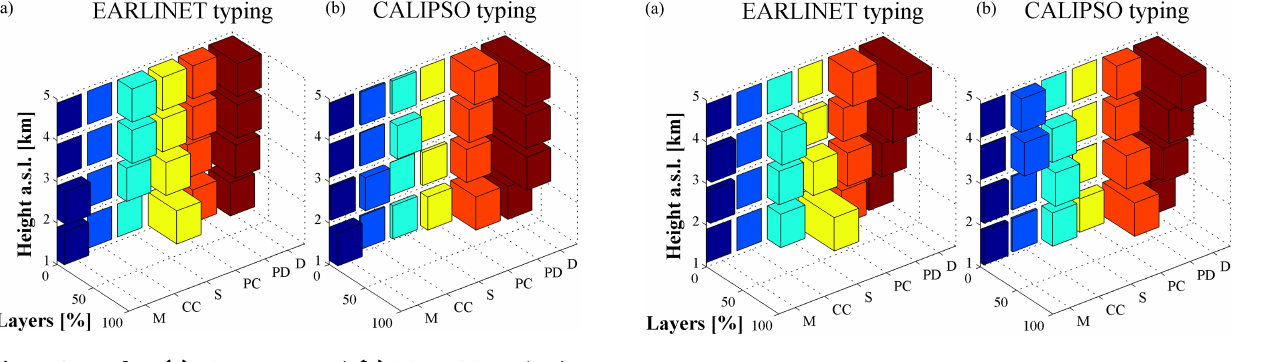
Figure 10. Potenza: (a) EARLINET and (b) CALIPSO typing bar plots for 1km range increment. M stands for marine, D for dust, PC for polluted continental, CC for clean continental, PD for polluted dust, and S for smoke